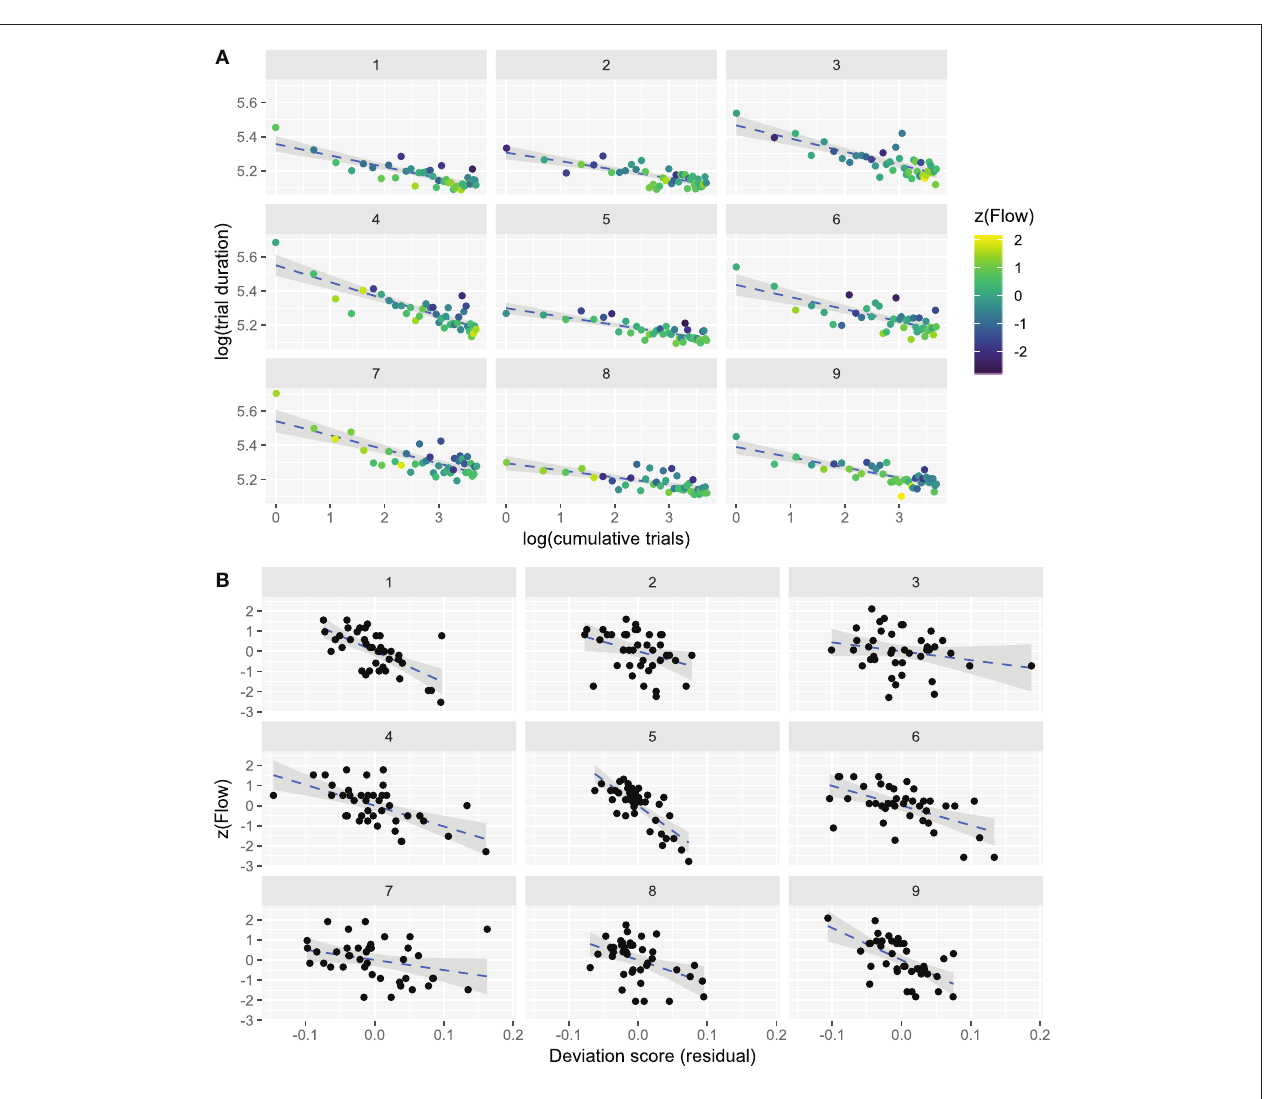
FIGURE 3 | (A) Participant-wise data showing logarithm-transformed performance and Flow self-reports in the speeded steering task. Ordinate shows log-duration of trials, abscissa shows log-cumulative trial count. Dashed blue lines fitted to the data are power-law learning curves, which transform to linear in log-log space. 95% confidence intervals around the slope are grayed. Flow scores (z-scored) are indicated by color. (B) Participant-wise deviation scores (observed trial duration minus predicted trial duration) plotted against Flow scores for each participant, and fitted by linear models. 95% confidence intervals around the slope are